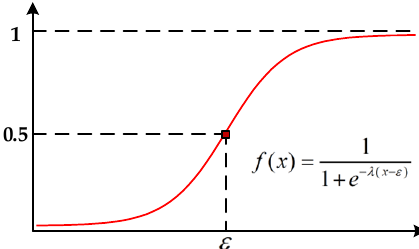
ε . Figure 6. The Sigmoid function with scaling parameter